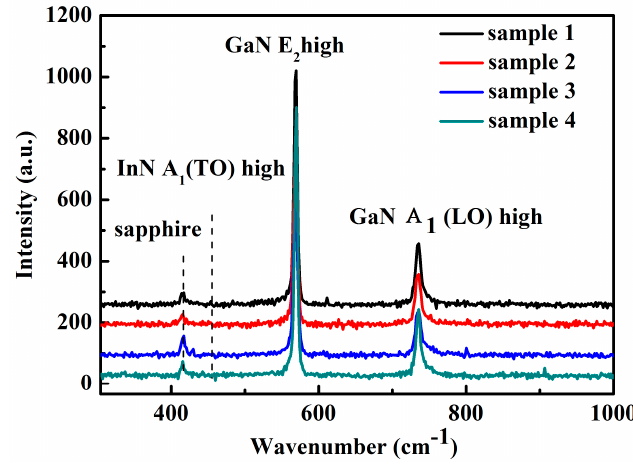
Figure 3. SEM images of AlInGaN epilayers grown with different TMA flow rate.